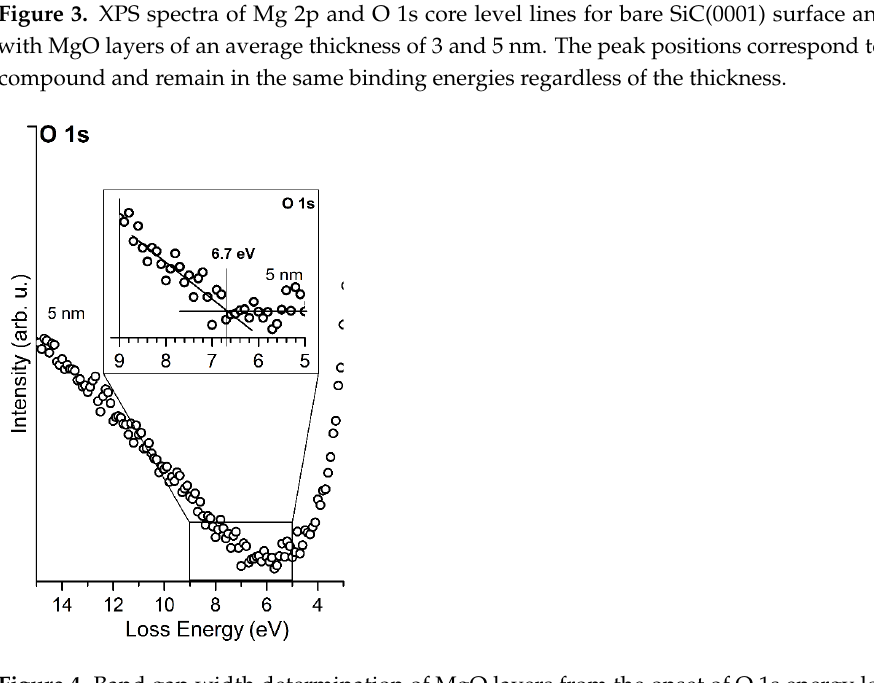
Figure 4. Band gap width determination of MgO layers from the onset of O 1s energy loss spectra. The average thickness of the layer is 5 nm.